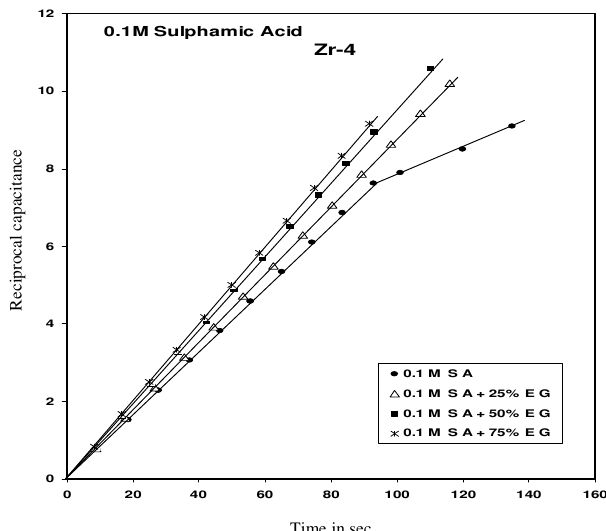
Figure 2. Plot of reciprocal capacitance as a function of time in aquo-glycolic solution Table 1. Effect of solvent on the anodization of zircaloy-4 in 0.1M sulphamic acid Electrolyte Formation Rate, V.s -1 Η , % F